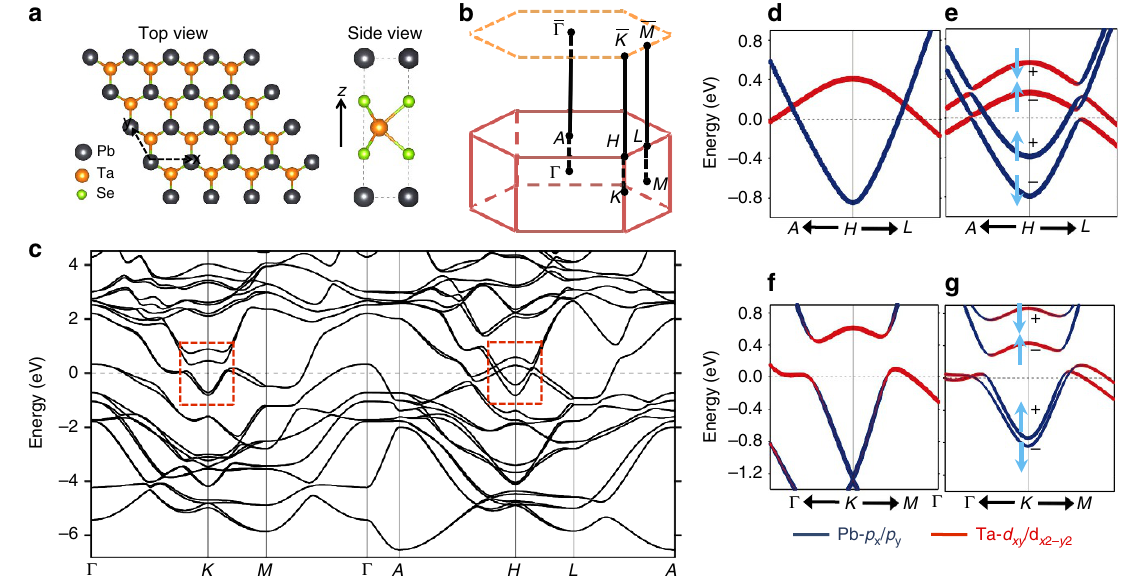
Figure 2 | Lattice structure and bulk bands of PbTaSe 2 . ( a ) Hexagonal lattice of PbTaSe 2 . ( b ) Bulk band structure of PbTaSe 2 . ( c ) Calculated bulk band structure of PbTaSe 2 . ( d , e ) Zoom-in band structure around H without/with the inclusion of SOC. The colour code (red and blue) shows the orbital components. The up and down arrows indicate spin up and spin down along the z axis, respectively. ( f , g ) Same as d , e but for band structure around K . The bands in e , g correspond to those in the red rectangular boxes in c .